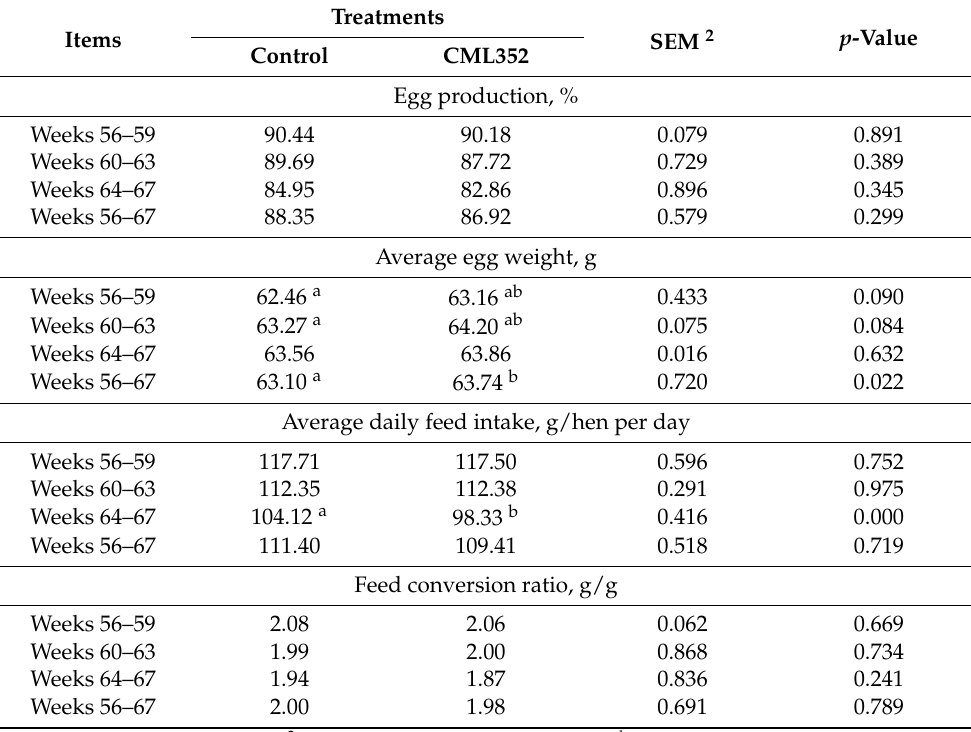
Table 8. Effects of dietary supplementation with L. salivarius on laying performance 1